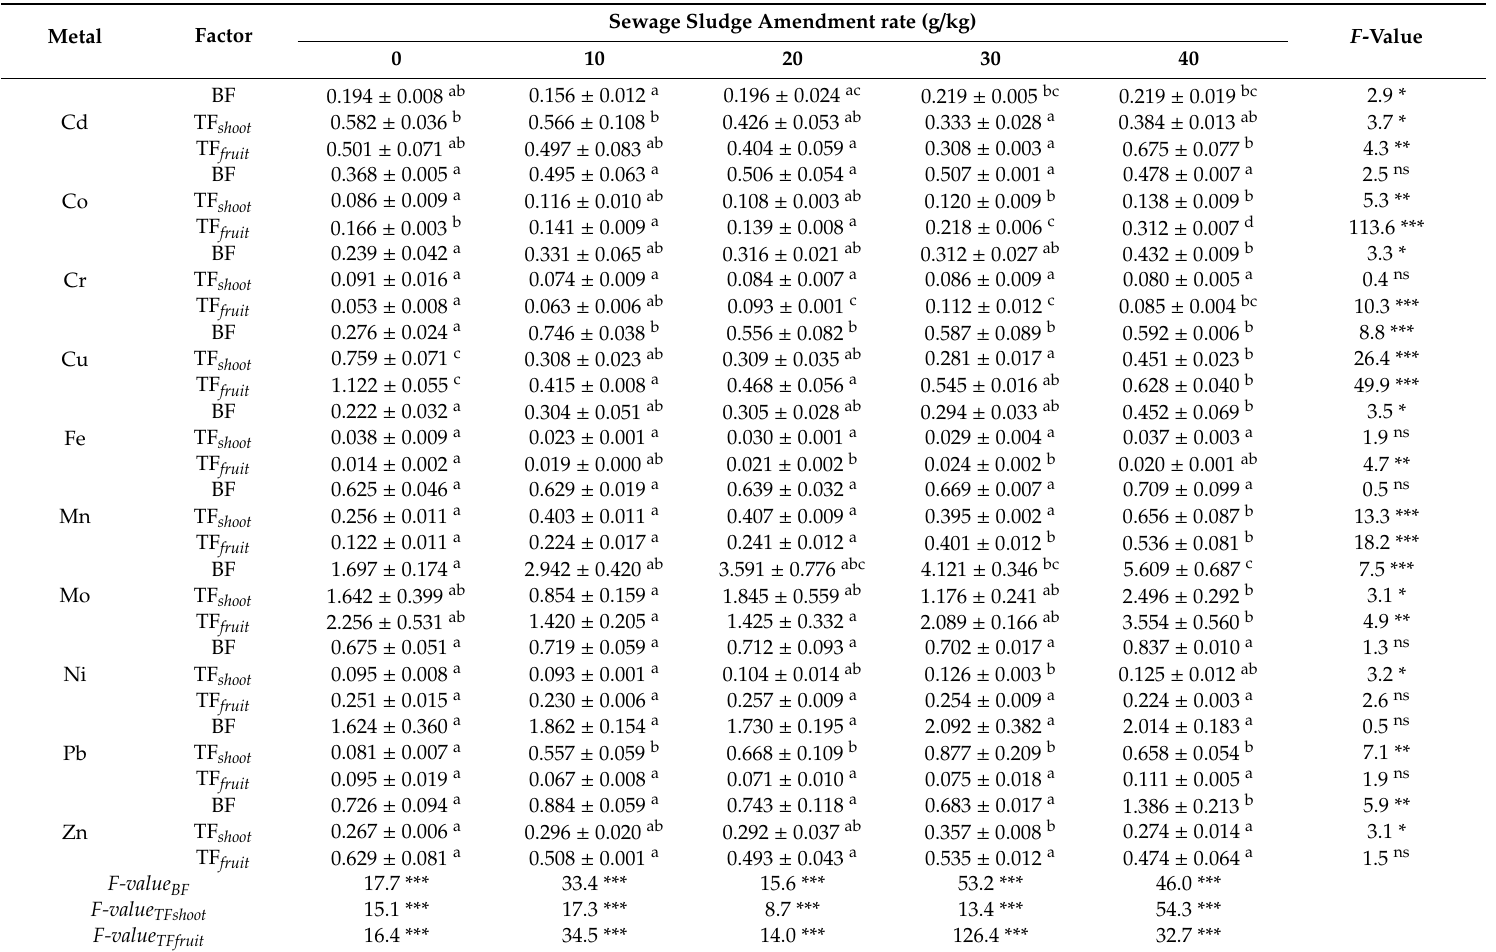
Table 5. Bioaccumulation factors (BFs), from soil to roots, and translocation factors (TFs), from roots to fruits and shoots, of heavy metals in Pisum sativum grown in soil with di ff erent sewage sludge amendment rates (means ± standard error, n =